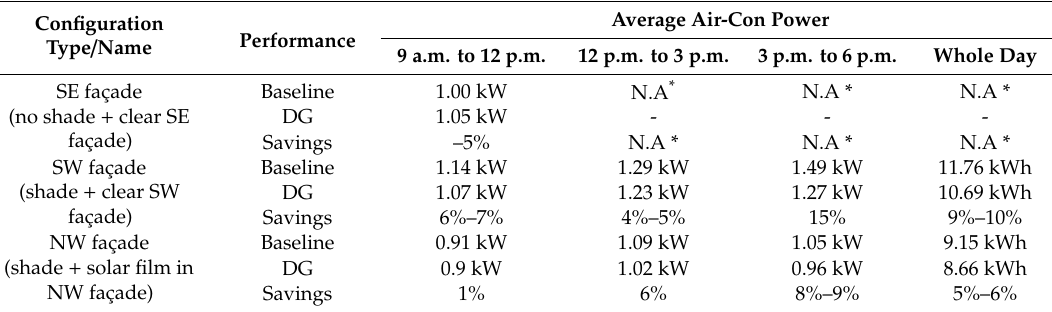
Figure 6. Comparative plots before and after retrofit double glazing of NW façade: ( a ) Façade heat flux; ( b ) indoor normal irradiance; ( c ) illuminance level at room center.